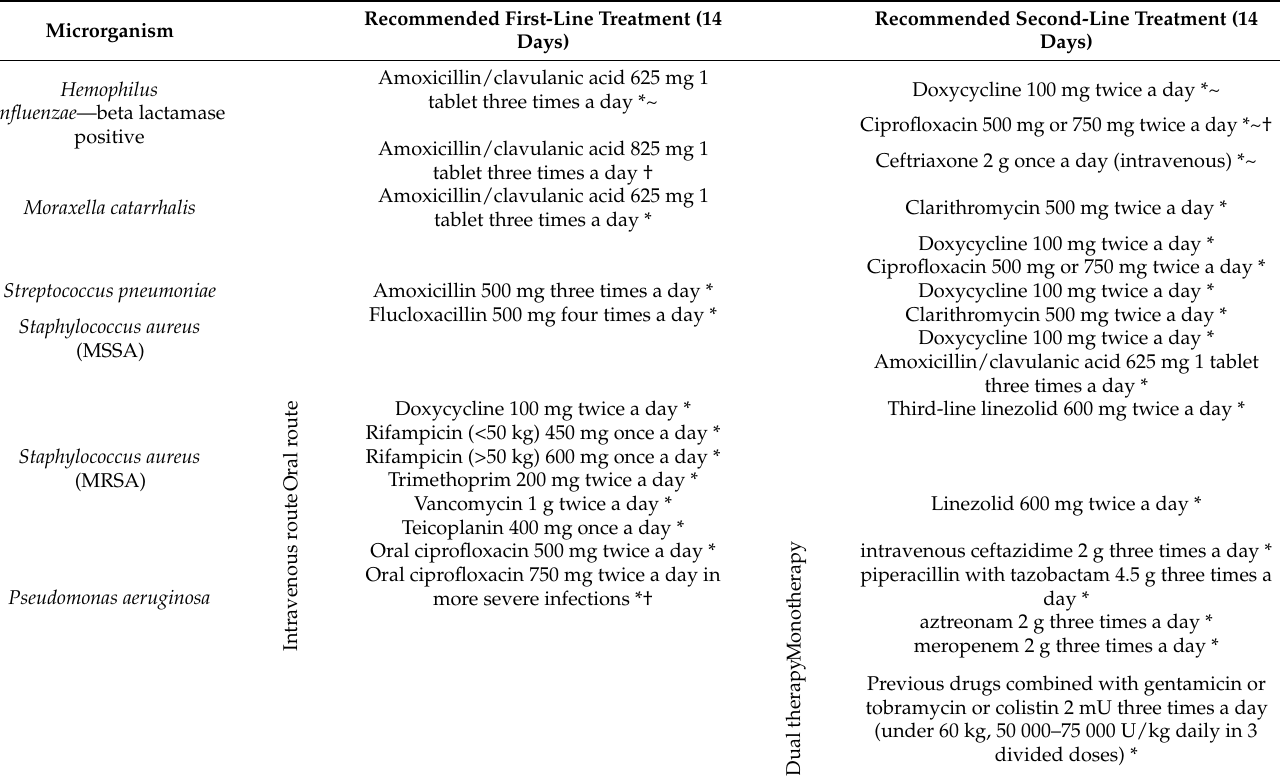
Table 2. Recommended antibiotic treatment according to the most common microorganisms found in exacerbated bronchiectasis. Recommended First-Line Treatment (14 Recommended Second-Line Treatment (14 Microrganism Days)